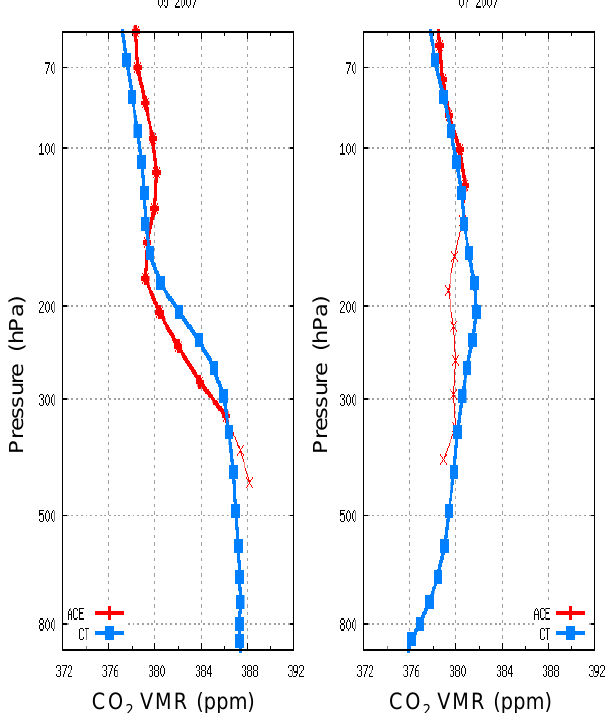
Fig. 8. CO 2 concentration (x-axis inppm) evolution with pressure (y-axis in hPa) for May (left) and July (right) of 2006 for the 50 ◦ N– 60 ◦ N latitude band. ACE-retrieved profile is in red, CT profile is in blue and Flexpart profile is in purple. ACE thin red line indicates that less than 10 occultations were available. ACE CO 2 standard de- viation at each altitude (not shown in the picture) fluctuates around 3ppm ( ± 1ppm).